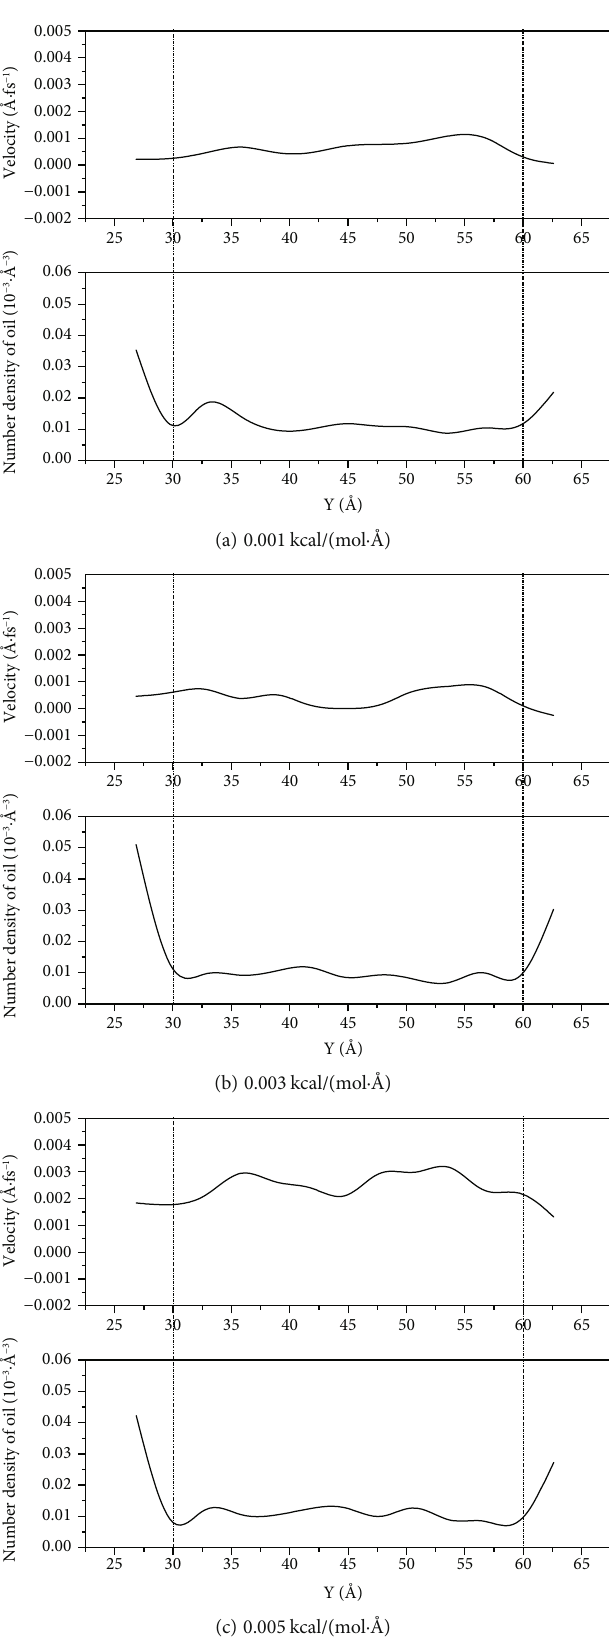
Figure 12: The fl ow velocity and density distribution of oil under di ff erent driving forces in the Y direction at